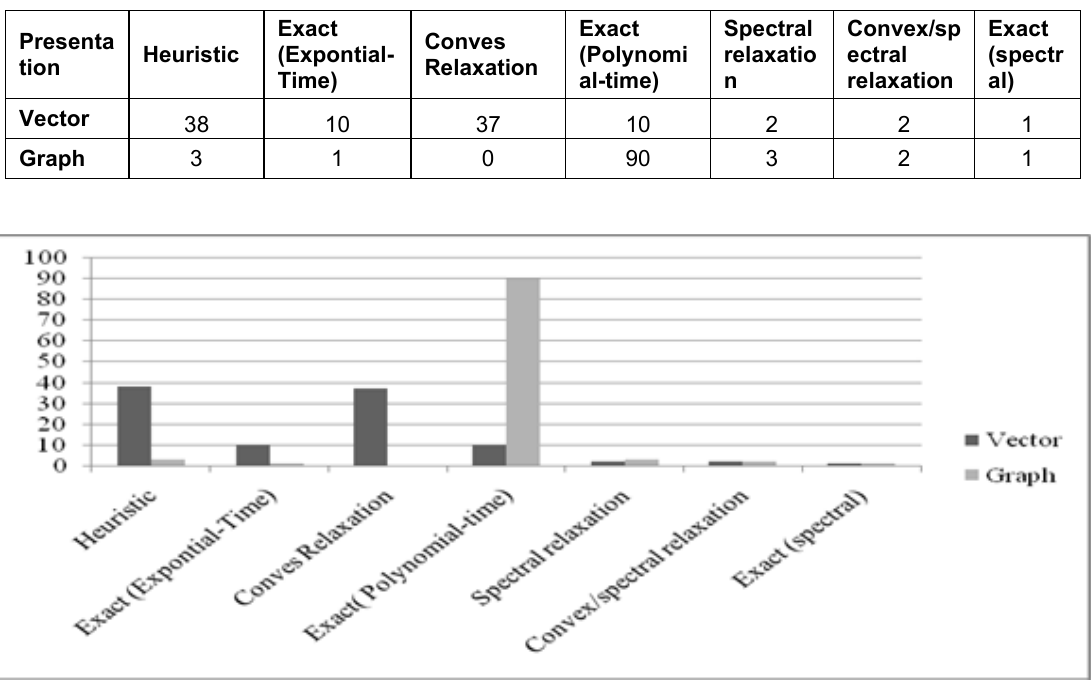
Figure 2. Chart representing approaches and presentation of data Table 3. Approach in percentage (%) can be applied for unsupervised